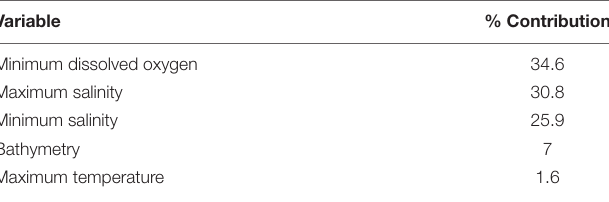
TABLE 1 | Analysis of variable